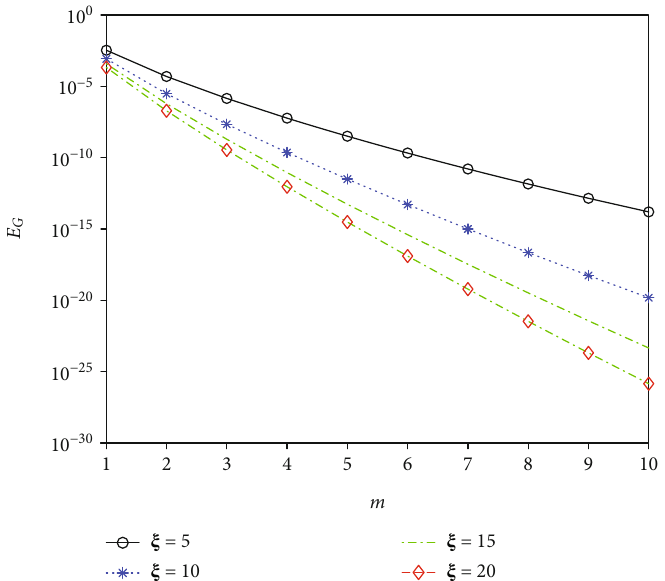
Figure 25: Variation of solution error E against increasing order ð m Þ of LSPM series approximation for di ff erent values of ξ , when n = G = 0 : 6, Ω = 0 : 1, and He = 0 : 2 0 : 5, K = 0 : 5, Pr = 10, S = 3, N R